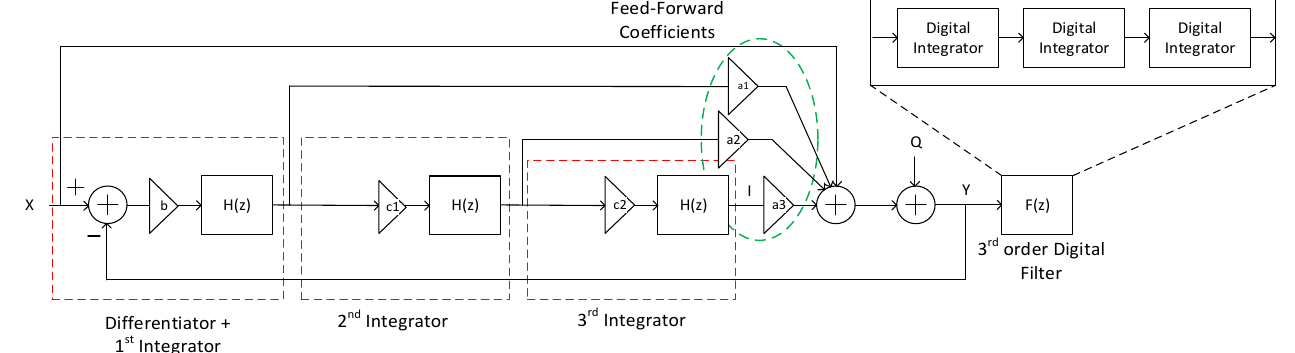
Figure 3. Implemented 3rd order cascade of integrators feed-forward incremental sigma-delta (ISD) column converter system. Additional emphasis to the digital filter implementation, namely three consecutive digital integrators in counting digital data in a row.